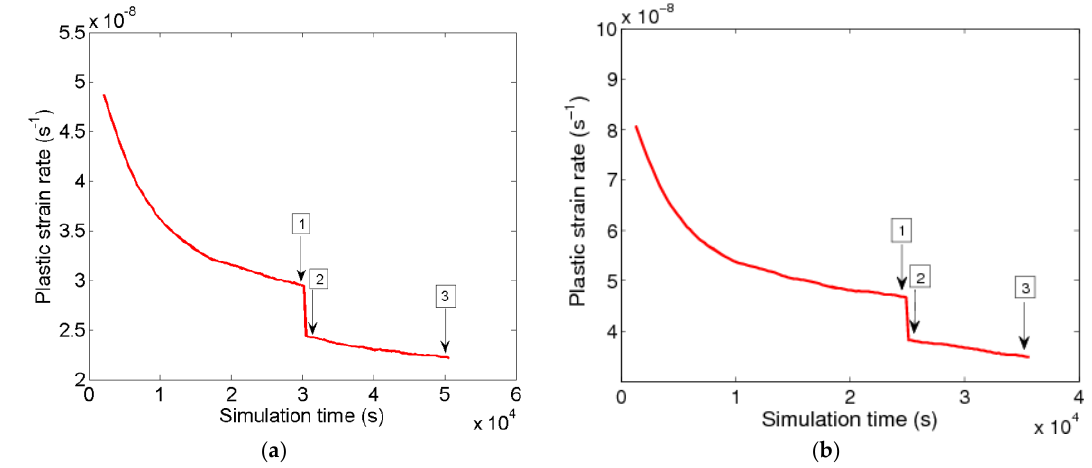
Figure 9. Abrupt change in plastic strain rate when the applied stress was reduced from 180 MPa to 160 MPa; ( a ) M glide = 8.67 × 10 −10 (Pa·s) −1 ; ( b ) M glide = 1.44 × 10 −9 (Pa·s) −1 .